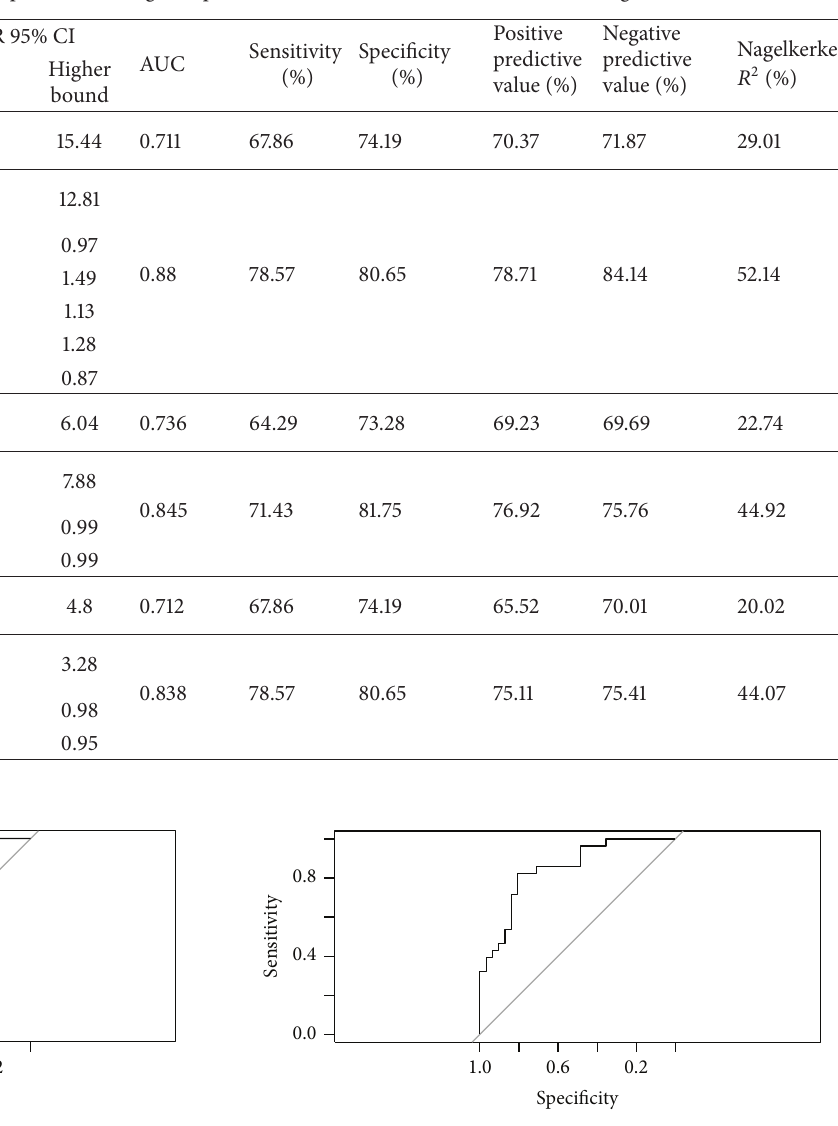
Figure 4: ROC curve for model MOD-B1. Figure 5: ROC curve for model